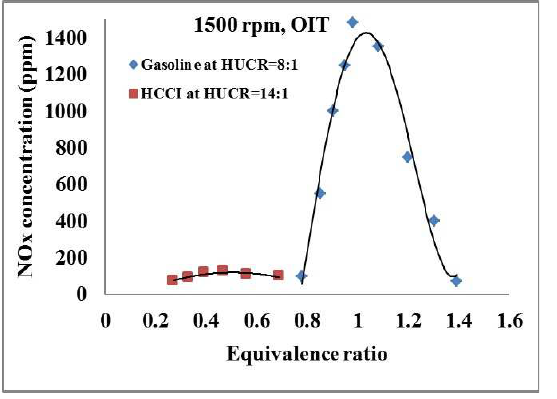
Fig. 11. NOx concentrations of the two systems at HUCR for each one, for wide range of equivalence ratio